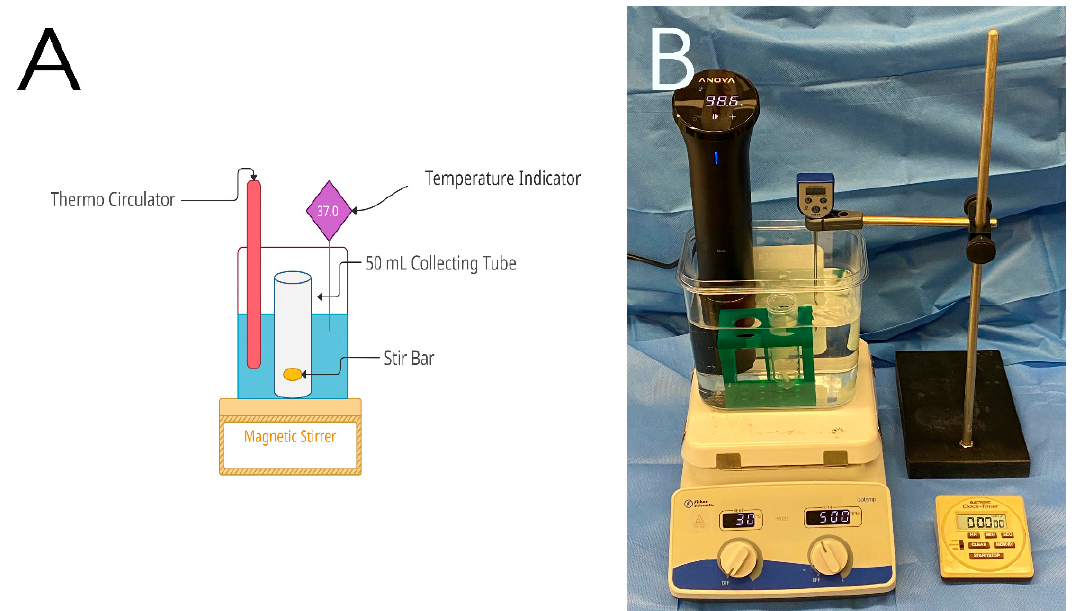
Figure 2. A rapid dissolution apparatus used in this study. ( A ) schematic description of the apparatus and ( B ) the used set-up in this study (37 °C, 500 rpm).